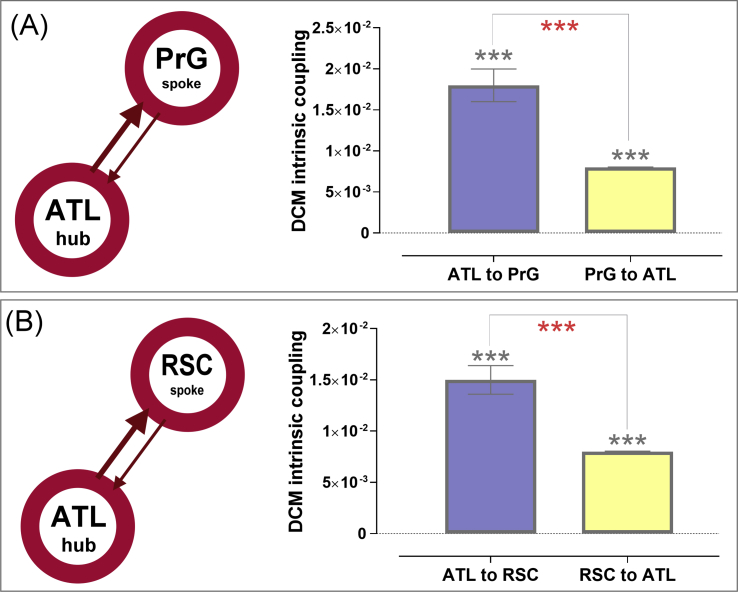
Analysis of DCM on the intrinsic coupling between the domain-general ATL hub and content-specific spoke (A: Experiment 1, with the action-related precentral gyrus / PrG being the spoke; B: Experiment 2, with the place-related retrosplenial cortex / RSC being the spoke). The bar-charts show the magnitude of intrinsic coupling parameters. The diagram illustrates the structure of DCM; the thickness of arrows in the diagram depicts the outcome that the ATL's directional effect on the spoke was significantly greater than the effect the other way around. Localisation of the hub and spoke's coordinates was guided based on the results of prior GLM and PPI analysis.